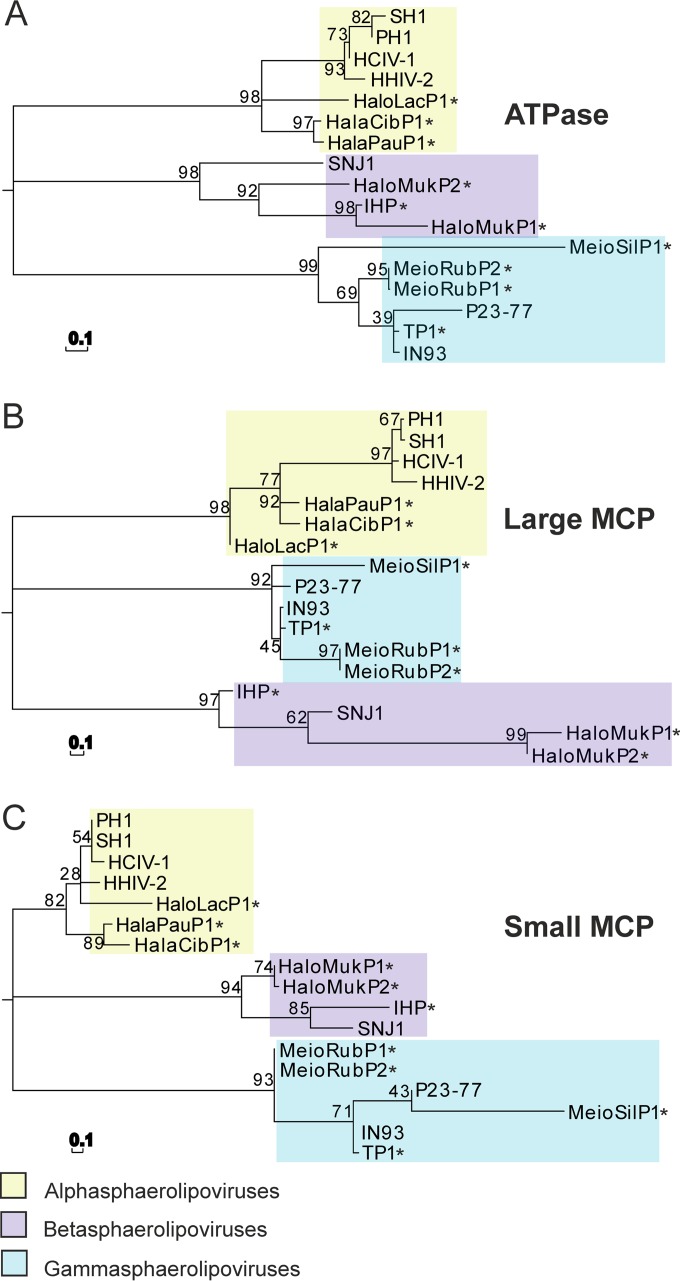
Phylogenetic analysis of conserved HCIV-1 proteins. Maximum likelihood phylogenetic trees of protein sequences of HCIV-1, sphaerolipoviruses, and related proviruses (marked with asterisks) are shown. (A) Putative ATPase. (B) Large MCP (VP4 in HCIV-1). (C) Small MCP (VP7 in HCIV-1). Evolutionary analysis was conducted using the JTT amino acid substitution model and 1,000 bootstrap values in MEGA 5.05. The bar (0.1) indicates the inferred number of substitutions per site.